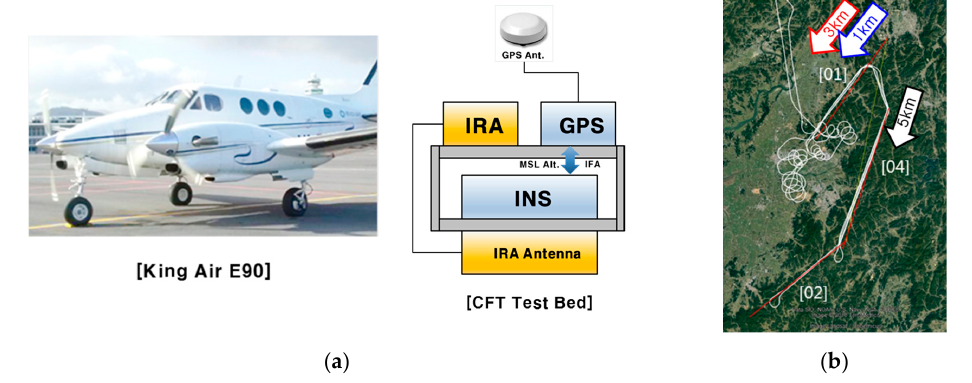
Figure 13. Flight test preparation ( a ) System configuration; ( b ) Trajectory [12]. Table 1. Information on flight trajectory.